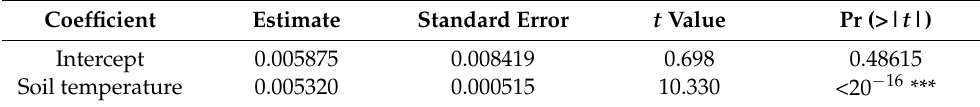
Table 2. Parameters of the linear model describing the effects of soil temperature on the CO 2 efflux from undisturbed bare soil under field conditions in Karcag, Hungary. Coefficient Estimate Standard Error t Value Pr (>| t |) Intercept 0.005875 0.008419 0.698 0.48615 Soil temperature 0.005320 0.000515 10.330 <20 − 16 ***